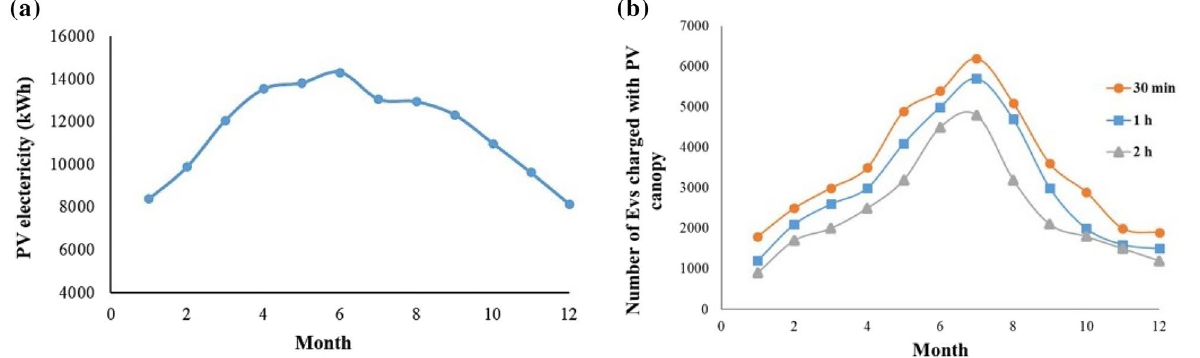
Figure 4. PV electricity (kWh) ( a ) and number of EVs charged with PV electricity ( b ) produced from carport canopy solar power in the study area.